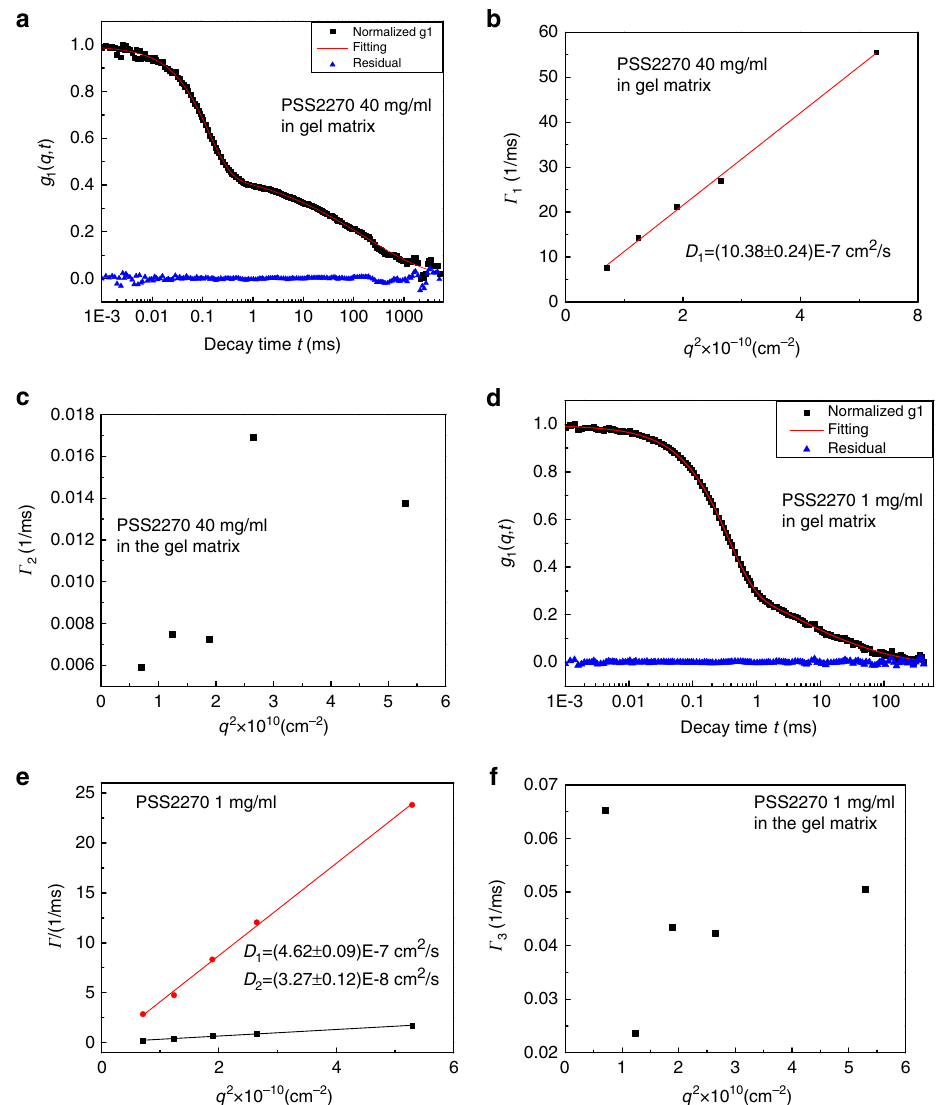
Fig. 5 Dynamics of polyelectrolytes in gel matrix. a , d Normalized fi eld-correlation function g 1 ( q , t ) of PSS2270 at 40 and 1 mg/mL, respectively, in gel matrix at scattering angle 30°. The blue triangles are the residuals between the original data (black) and the fi tting curves (red). b , c Fitting results of Γ vs. q 2 of different modes at all angles for PSS2270 at 40 mg/mL. e , f Fitting results of Γ vs. q 2 of different modes at all angles for PSS2270 at 1 mg/mL. All samples are with 0.1 M